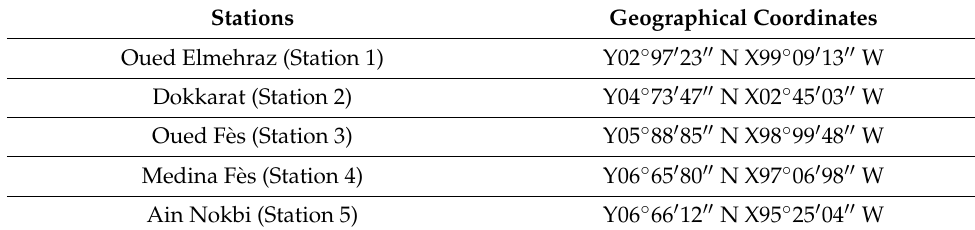
Table 5. Geographical coordinates of the stations visited. Table 1. Geographical coordinates of the stations visited.